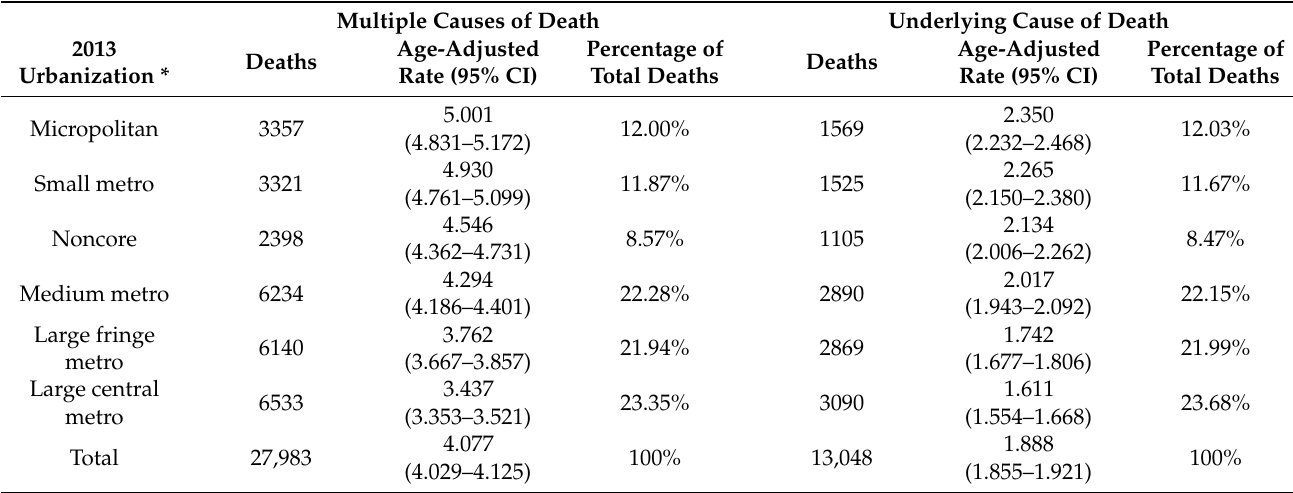
Table 3. Age-adjusted mortality rates per million for vasculitis as the underlying cause of death and multiple causes of death, by race and gender.